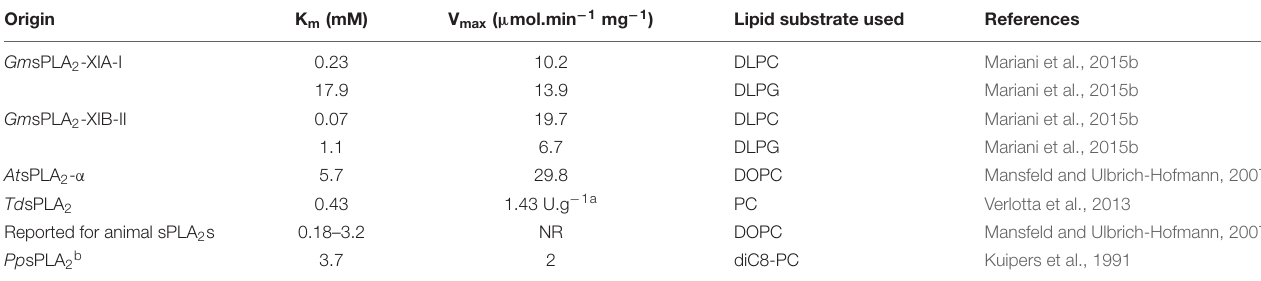
TABLE 9 | Kinetic parameters for some reported plant sPLA 2 .